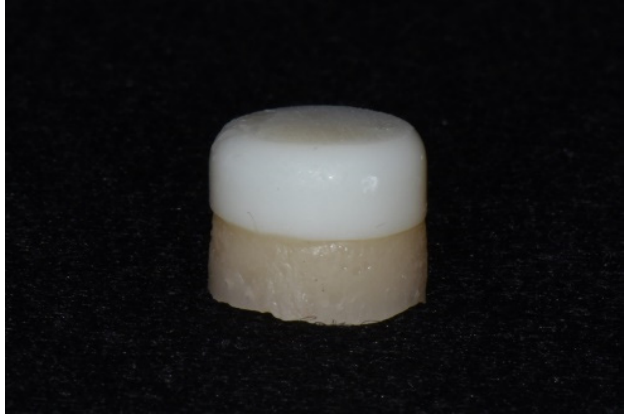
Figure 2. Specimens used in the experiment (Top: LiSi Press, Bottom: Charmfil flow).